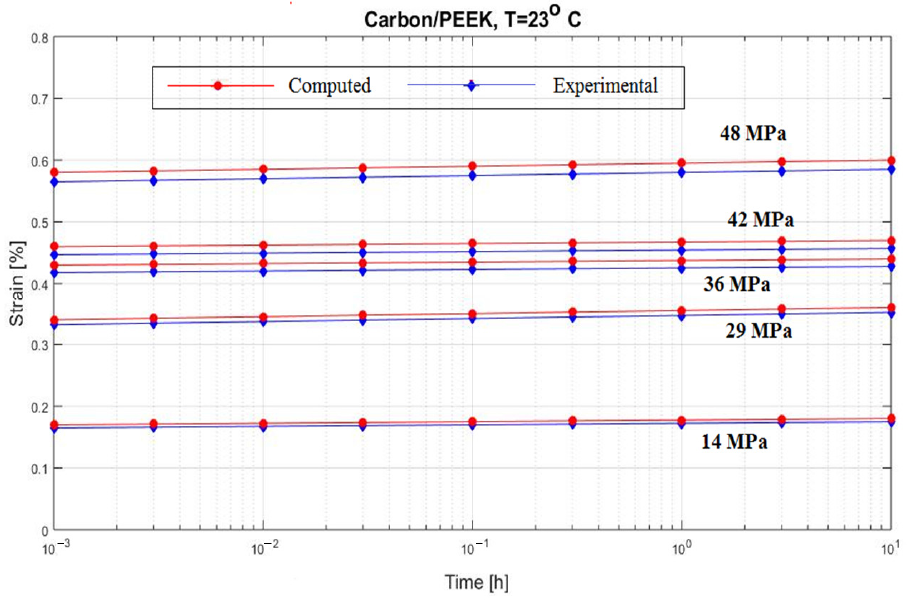
Figure 8. Creep response of a carbon/epoxy {90} 4s at T = 23 °C.